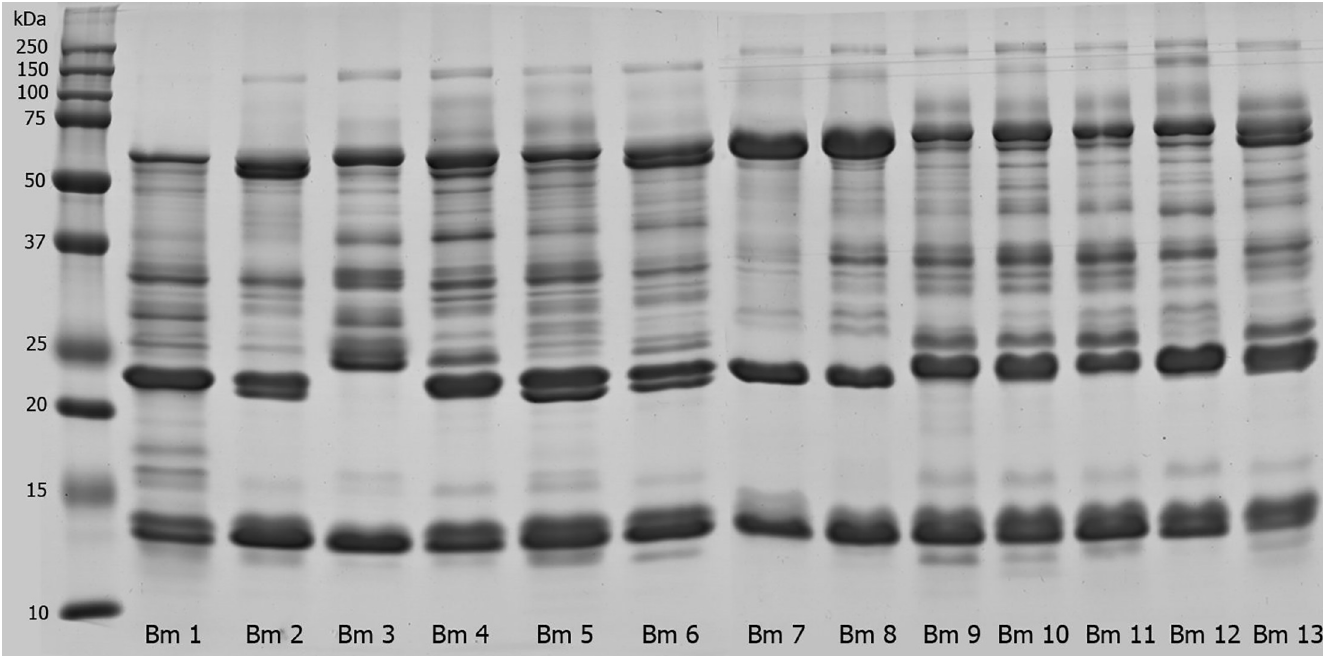
Fig 3. Protein profile of B . moojeni venom samples. B . moojeni venom samples (20 μ g) were individually analyzed by SDS-PAGE (15%) under reducing conditions. Gels were stained with Coomassie Blue G250. Lanes correspond to individual plasmas from specimens Bm1 to Bm13.